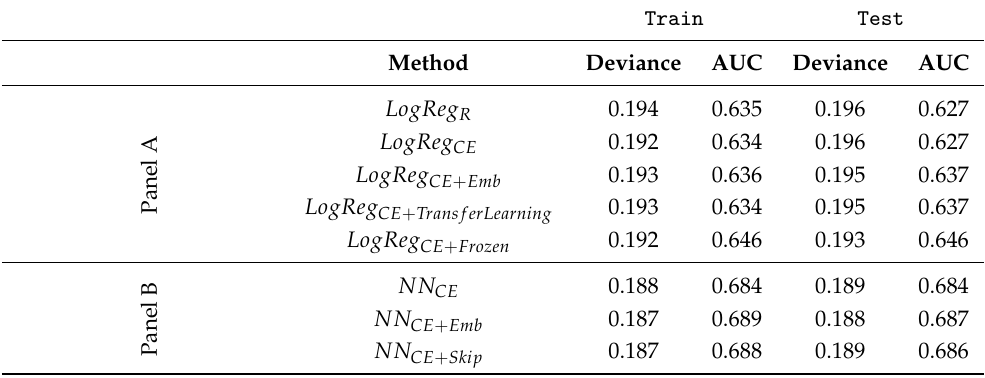
Figure 5. AUC values on the test set achieved using logistic regression with embeddings ( left ) and frozen weights learned by a neural network ( right ). Table 5. The cross-entropy loss and the corresponding AUC values on the training and test